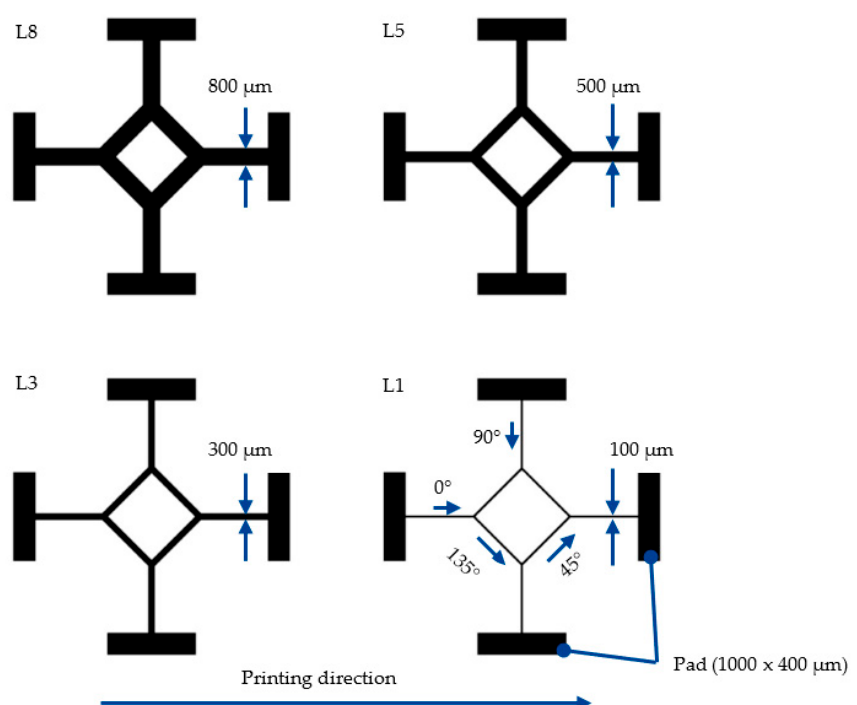
Figure 3. Printing layout design with labeled trace widths 100 μ m (L1), 300 μ m (L3), 500 μ m (L5) and 800 μ m (L8), traces twisted 0°, 45°, 90° and 135° to the printing direction and pads.